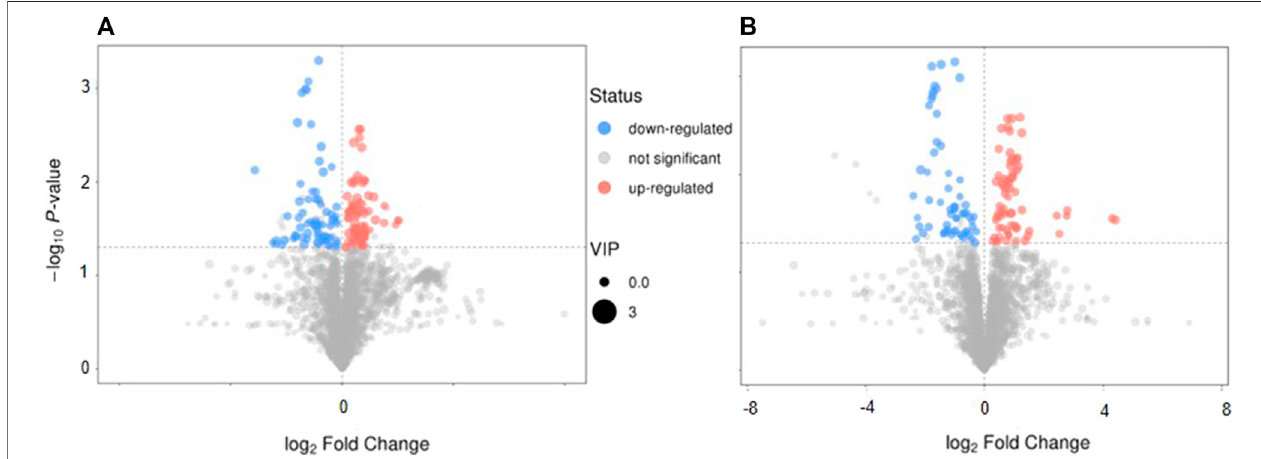
FIGURE 5 | The characteristics and pathway of serum metabolites. (A,B) Volcano map in positive-ion model and in negative-ion model, respectively. (C,D) The differentmetabolites pathway related withSAE werecon fi rmed,in positiveion model and innegativeionmodel, respectively. Red: up-regulation, blue: down-regulation, gray: not signi fi cant, * p <